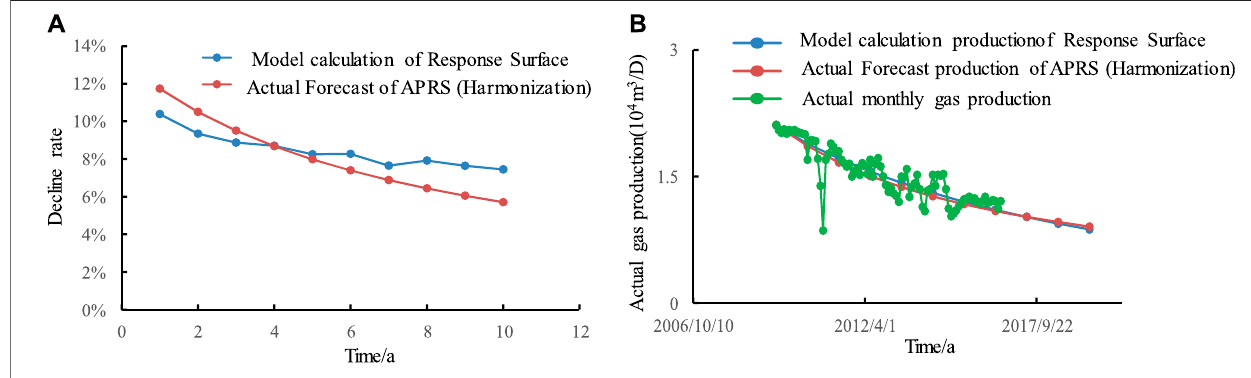
FIGURE 12 | Comparison of Response Surface for G1 and Traditional Method: (A) decline rate; (B) production.